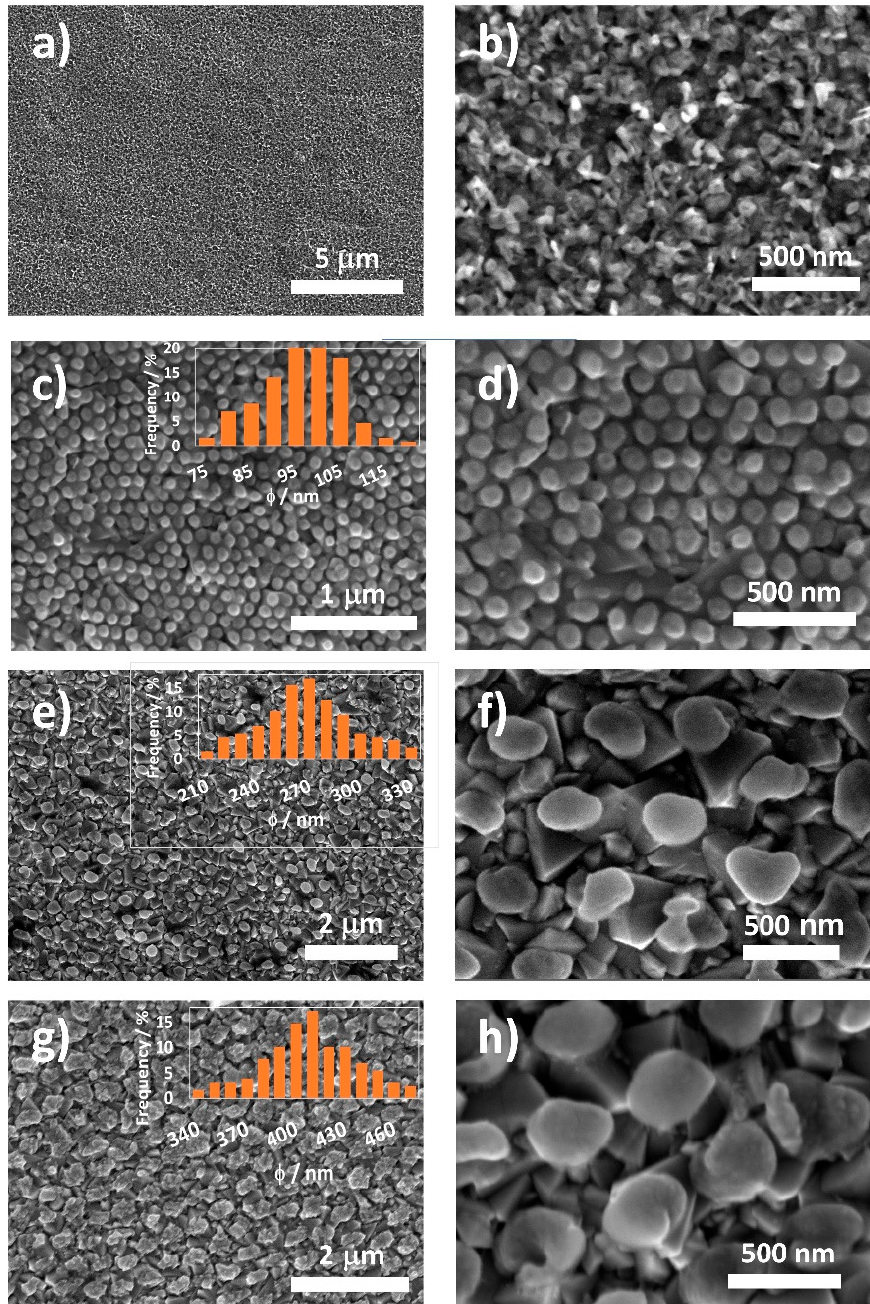
Figure 3. SEM top images of an iron oxide compact layer ( a , b ) synthesized by e-beam evaporation directly on a FTO substrate, and iron oxide nanopillars synthesized by e-beam evaporation using AAO templates with different diameters: φ 90 nm ( c , d ), φ 260 nm ( e , f ) and φ 400 nm ( g ), ( h ) on FTO substrates.